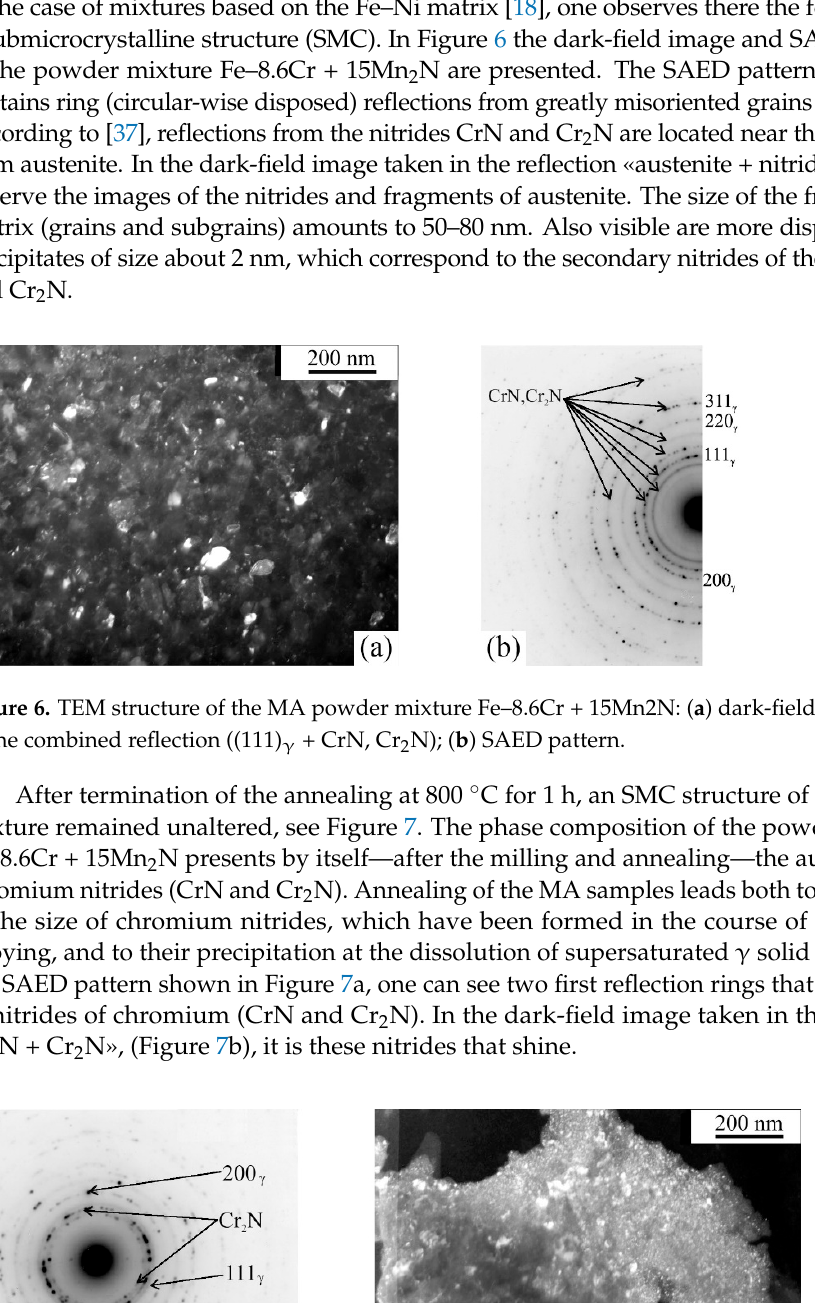
Figure 7. TEM structure of the MA powder mixture Fe–8.6Cr + 15Mn 2 N after annealing at 800 °C for 1 h: ( a ) SAED pattern; ( b ) dark-field image taken in the combined reflection (CrN, Cr 2